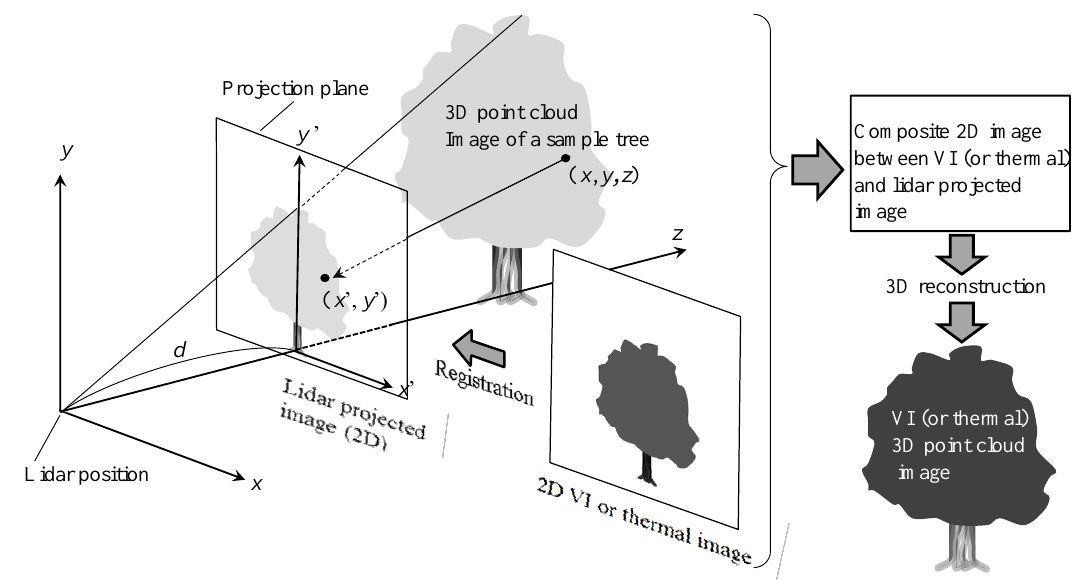
Figure 2. Image fusion between the 2D camera and 3D lidar-derived point cloud images of a sample tree. ( x , y , z ) and ( x’ , y’ ) are coordinates of a point in the 3D point cloud image and on the projection plane, respectively. d is distance between the lidar position and the projected plane.